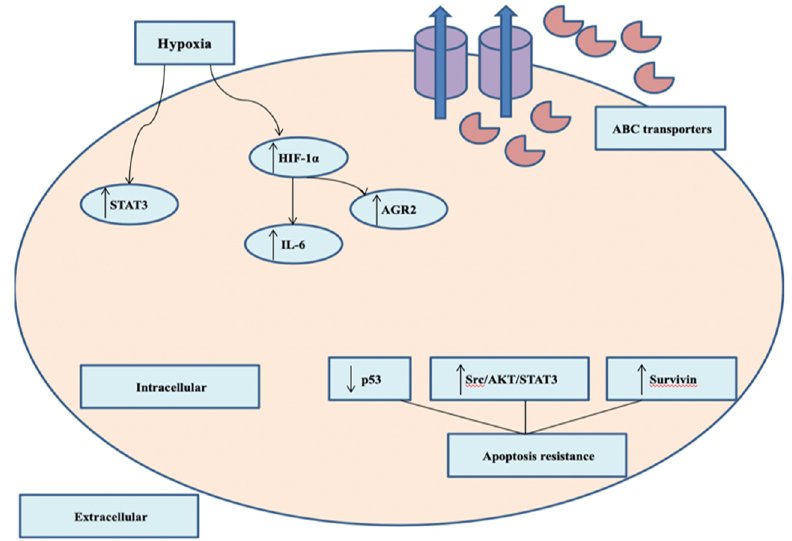
Figure 2. Major mechanisms of chemotherapeutics resistance in TNBC. Overexpression of ABC transporters and extruding chemotherapeutic agents out of the cancerous cells. Hypoxia induces upregulation of HIF-1 α and other signaling factors.